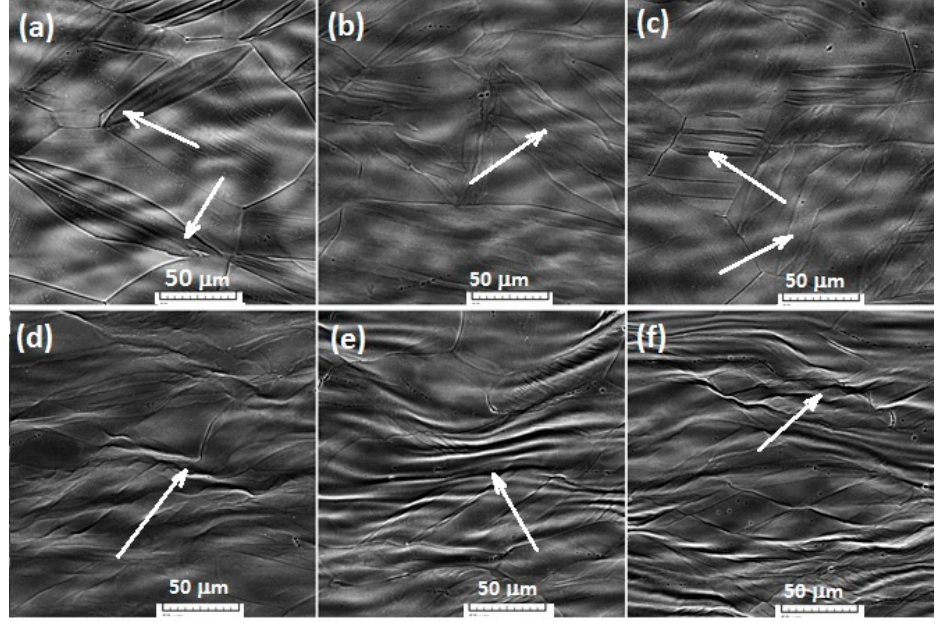
Figure 5. The SEM images of the Cold Rolling (CR) processed samples from the 1st step of the 1st direction of the TMP Program: ( a ) CR— ε tot = 10%; ( b ) CR— ε tot = 20%; ( c ) CR— ε tot = 30%; ( d ) CR— ε tot = 40%; ( e ) CR— ε tot = 50%; ( f ) CR— ε tot = 60%.